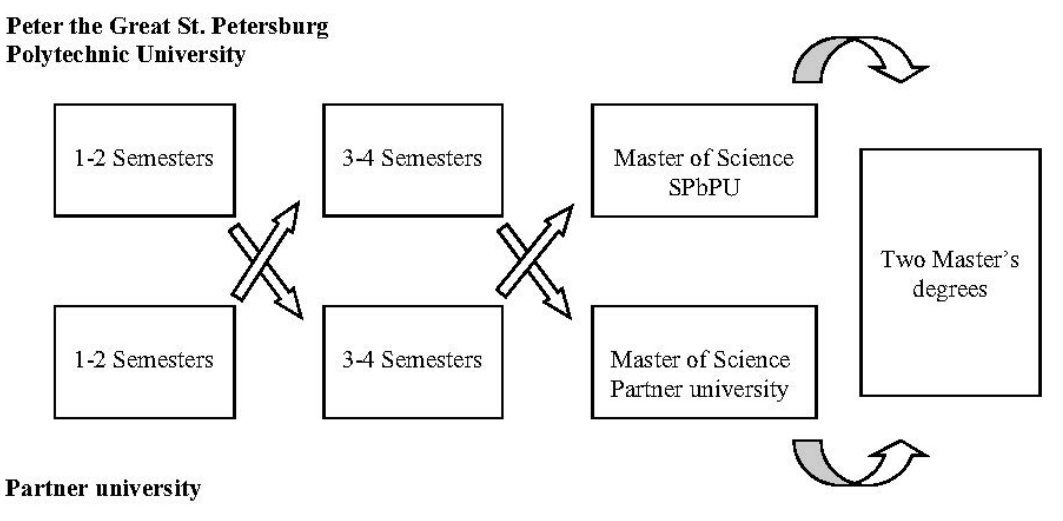
Figure 1 . Schedule of educational process in Master double degree